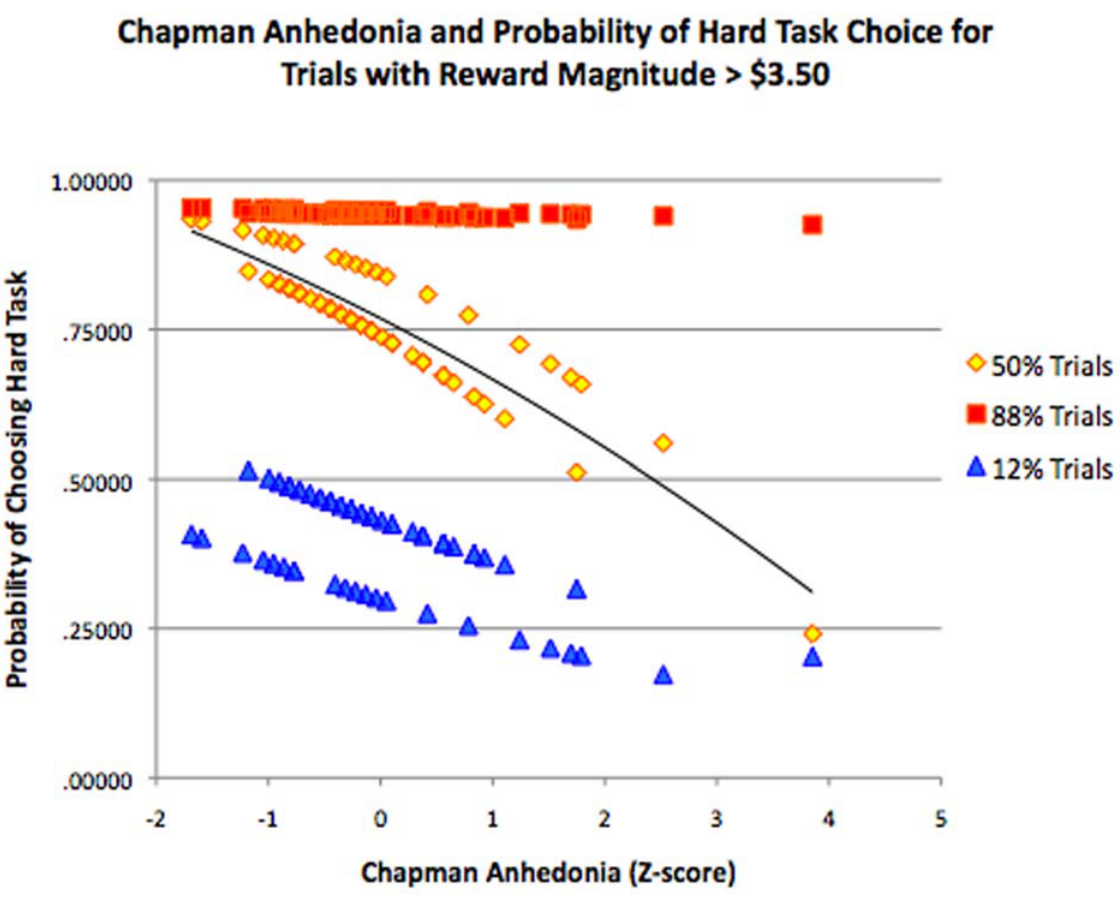
Figure 3. Relationship between Chapman anhedonia scores and GEE model predicted scores for trials with hard-task reward magnitudes . $3.50. Only trials at 50% probability level showed a significant relationship between anhedonia and model fit. The relationship between anhedonia and model fit for 50% probability trials was still significant after the outlier subject with the highest Chapman score was removed ( b = 2 .052, p =.002). The presence of two lines both yellow and blue trials reflects differences in model fit due to gender.